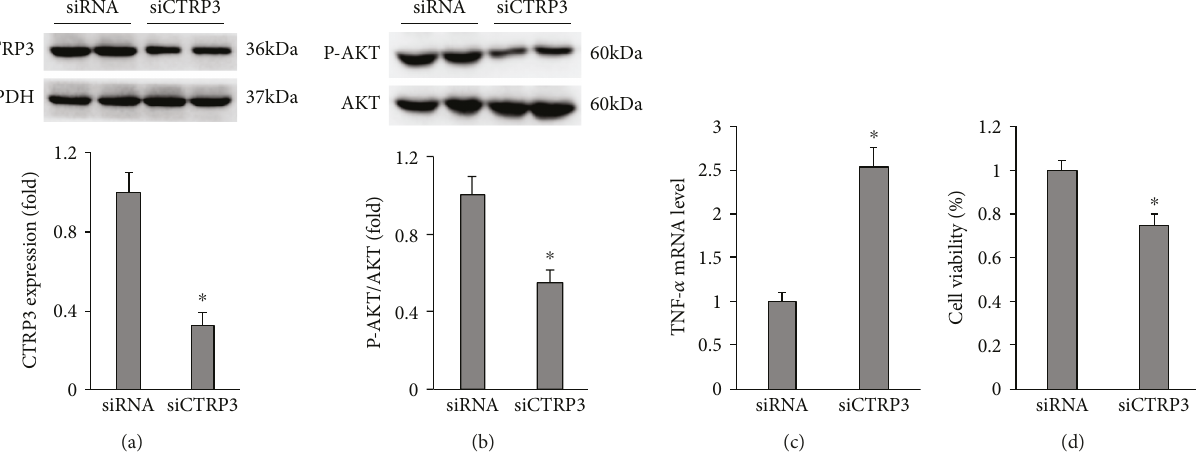
Figure 5: CTRP3 de fi ciency increased in fl ammation and cell death at baseline. (a) Protein level of CTRP3 ( n = 5 ). (b) The protein expression of AKT was detected by western blot analysis ( n = 5 ). (c) The mRNA expression of in fl ammatory factor in HUVECs ( n = 5 ). (d) Cell viability in HUVECs ( n = 5 ). Data are expressed as mean ± SD of fi ve independent experiments. ∗ P < 0 05 when compared to the matched